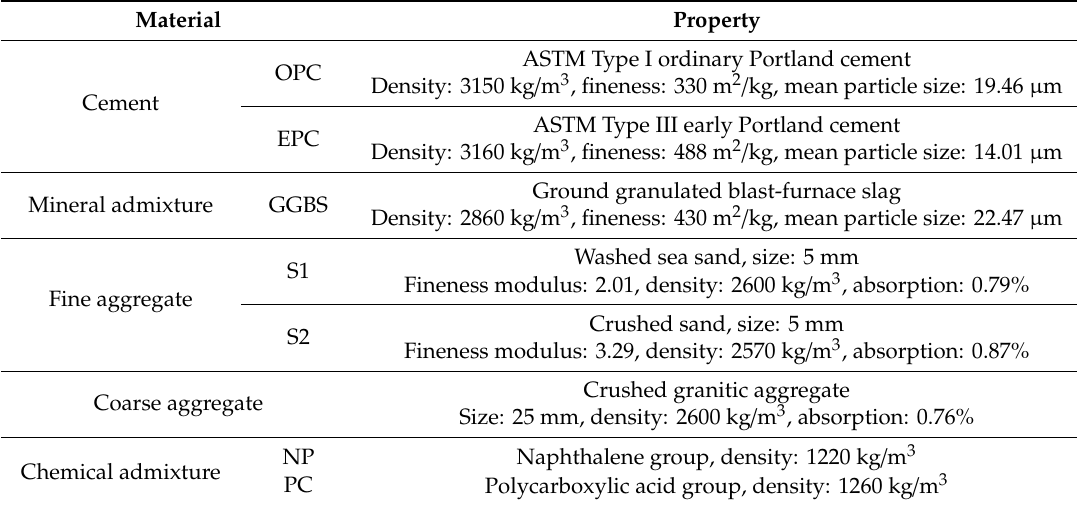
Table 1. Physical properties of the used materials.